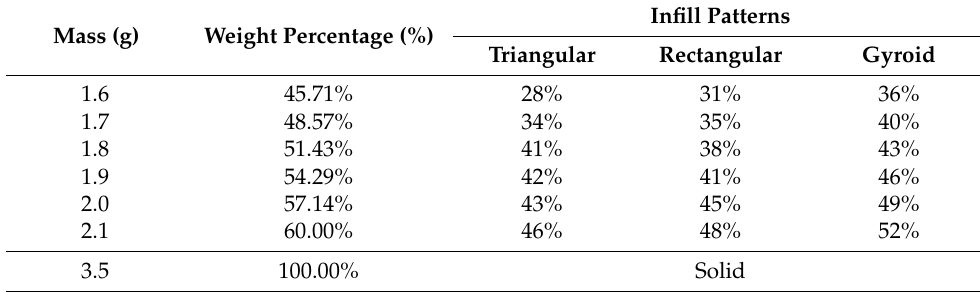
Table 3. Mass of compressive specimens with different infill patterns and